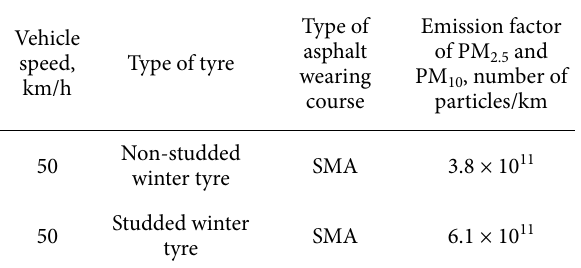
Table 1. Emission factor of PM 2.5 and PM 10 (number of particles/km) depending on asphalt wearing course by Johansson et al. 2007 Vehicle speed, Type of tyre km/h